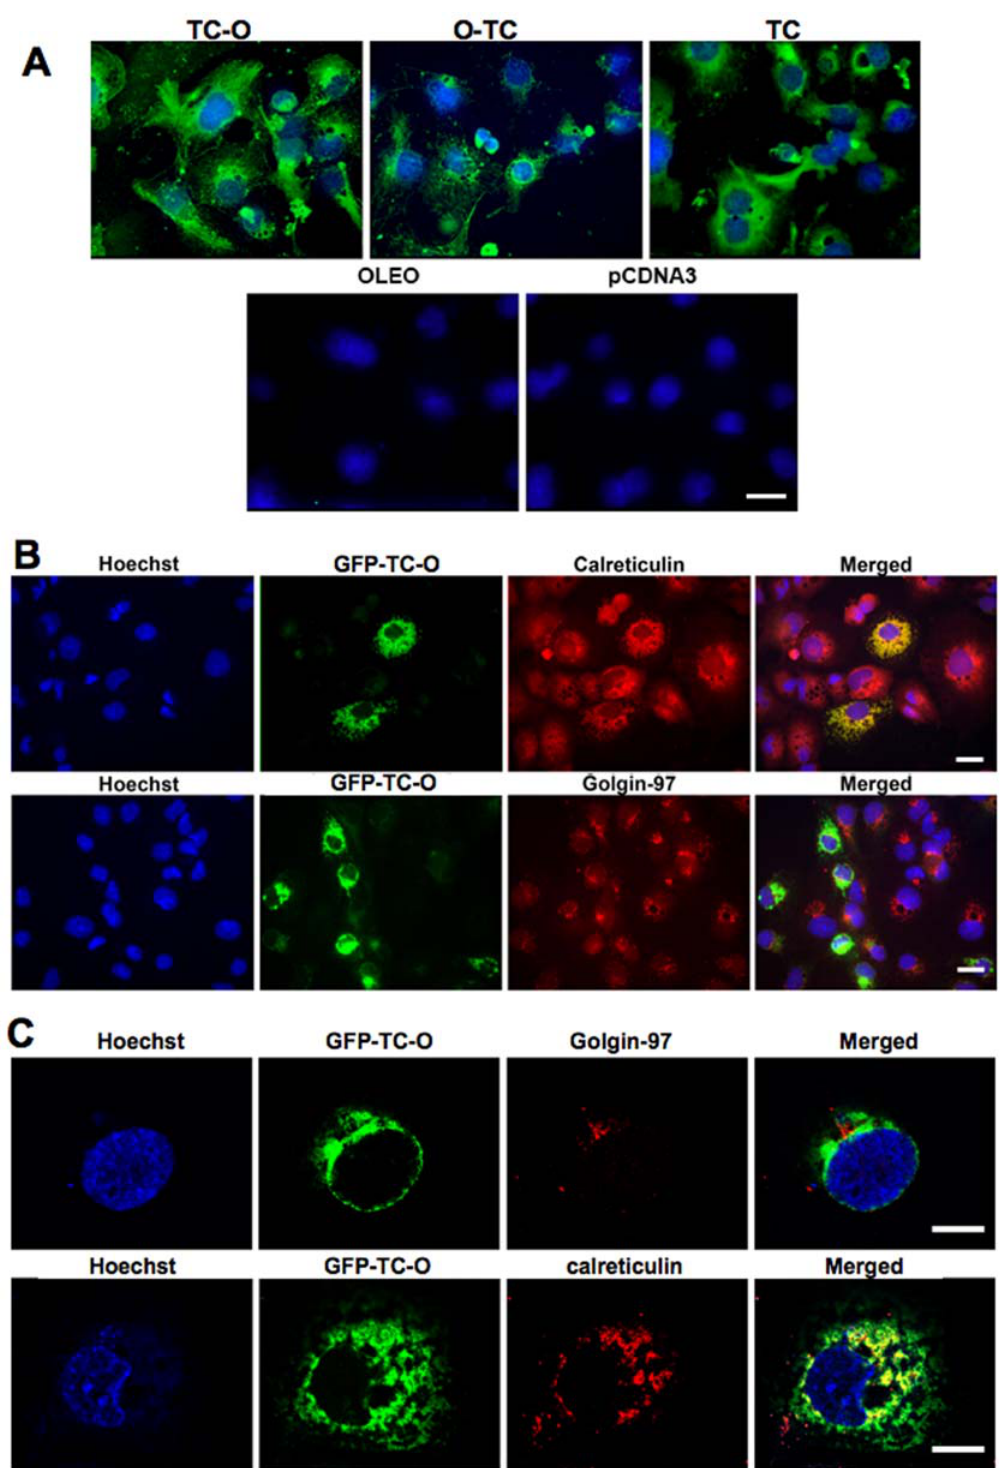
Figure 5. (A) Confocal microscopic examination of transcobalamin in COS-7 cells transiently transfected with lipofectamine. The cells were transfected with one of the following pCDNA3-plasmids: TC-O coding for transcobalamin-oleosin (TC-O), O-TC coding for oleosin-transcobalamin (O- TC), TC coding for transcobalamin (TC), O coding for oleosin (O), and the empty plasmid (pCDNA3). The immuno-fluorescence was done with a goat polyclonal antibody to TC and a donkey antigoat IgG fluorescin labeled. Cell nuclei were counterstained with Hoechst 33258. Calibration bars=20 m m. (B and C) Co-localization of the protein GFP-TC-O with endoplasmic reticulum in transient transfected Cos-7 cells using lipofectamine. The cells were transfected with the plasmid GFP-TC-O coding for GFP-transcobalamin-oleosin (GFP-TC-O). The immuno-fluorescence was done with a mouse monoclonal antibody to the human golgin-97 or a rabbit polyclonal antibody to calreticulin. The secondary antibodies were a donkey IgG anti-mouse TRITC labeled or a donkey IgG anti-rabbit TRITC labeled. Cell nuclei were counterstained with Hoechst 33258. Calibration bars=20 m m.